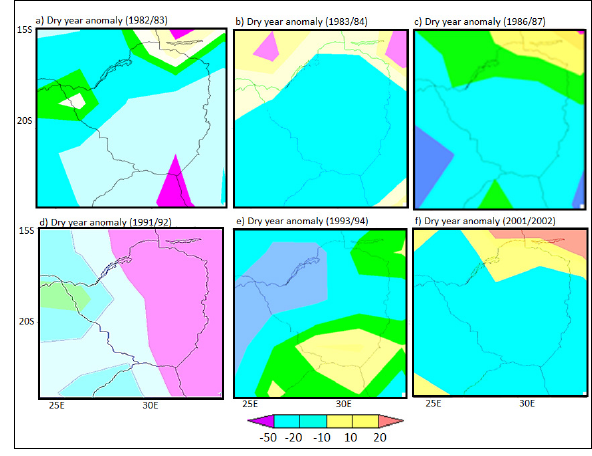
Figure 8: Rainfall distribution maps (in mm) for Zimbabwe for six wet years over the December–February months. Spatial distribution of summer rainfall in Zimbabwe for dry years Figure 9a and 9b show the composite maps for mean rainfall and anomalies in dry years. It can be deduced that the rainfall for Zimbabwe during dry years also follows the pattern for the long-term mean with a northeast to southwest gradient. The highest amount of precipitation is 120 mm monthly mean). The lowest rainfall is in the southwest and southeast regions in the Chiredzi, Masvingo, Beit Bridge and Plumtree areas (<60 mm monthly mean).